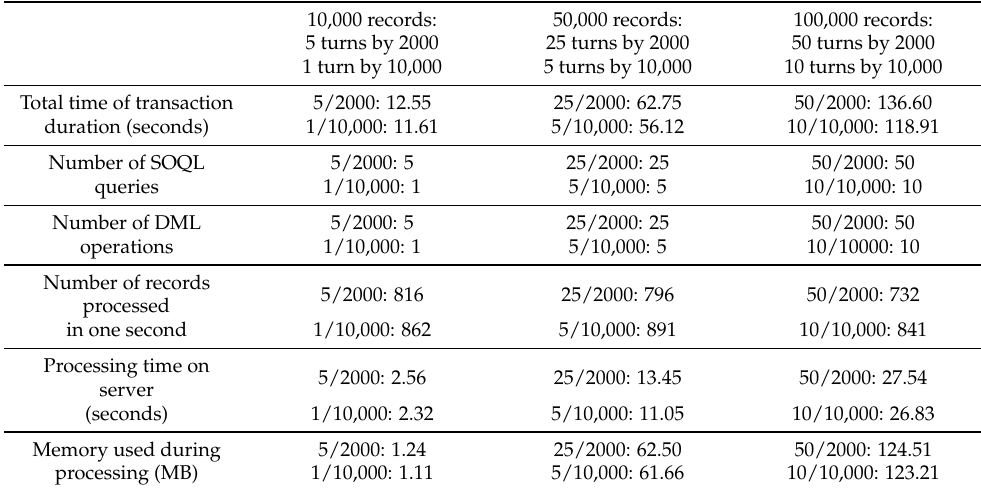
Table 9. Apex Queueable processing results for update